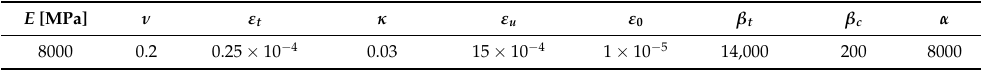
Table 4. Material parameters adopted for the numerical